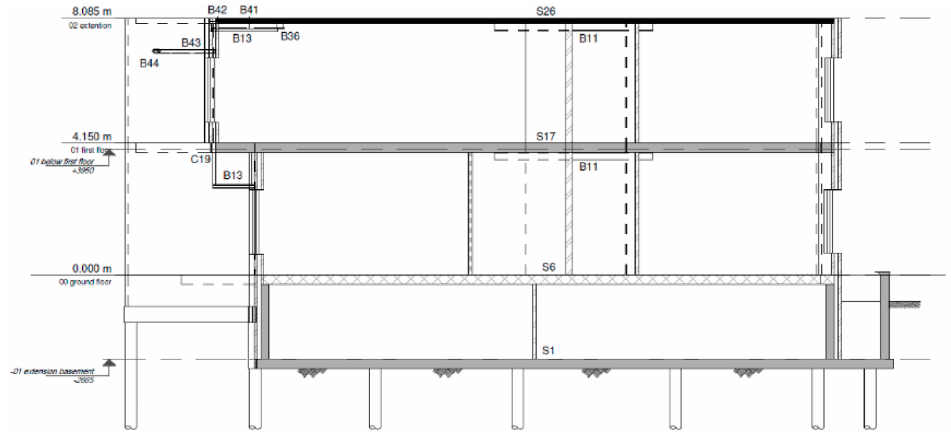
Figure 2. Building with basement case study: structural drawing (Witteveen+Bos, 2019) [14] of the portion selected for this study.